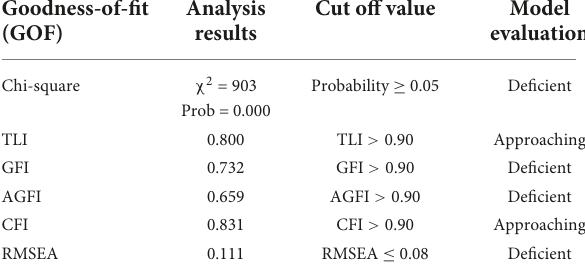
TABLE 12 Goodness-of-fit model. Goodness-of-fit (GOF)